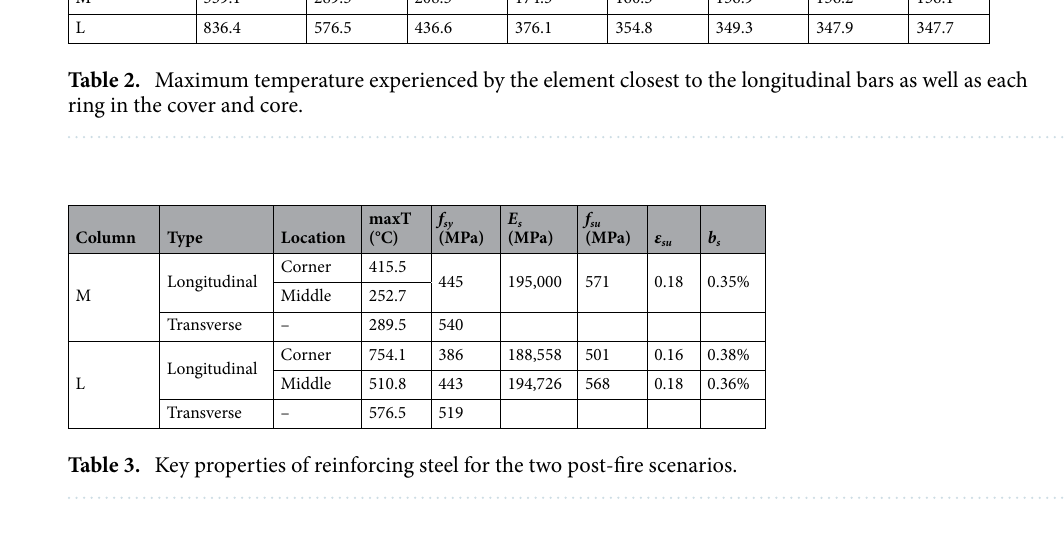
Table 3. It should be noted that the location of the longitudinal reinforcement (i.e., whether it is in the corner or the middle of the cross section) affects the reinforcing bar properties only for the most extreme scenario con- sidered, and even in this case the changes are small (i.e., maximum difference in properties 13%). The post-fire residual properties of the transverse reinforcement are also estimated by the Tao et al. 18 model and are presented in Table 3.